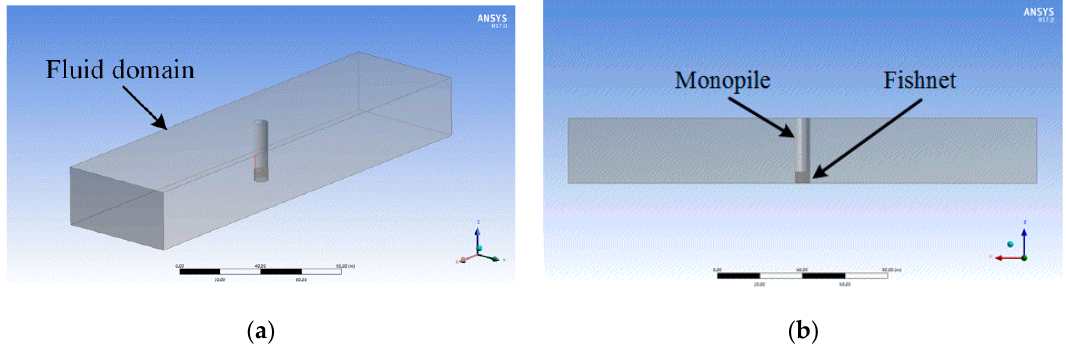
Figure 4. Fluid domain in the numerical model: ( a ) isometric view; ( b ) rearview.